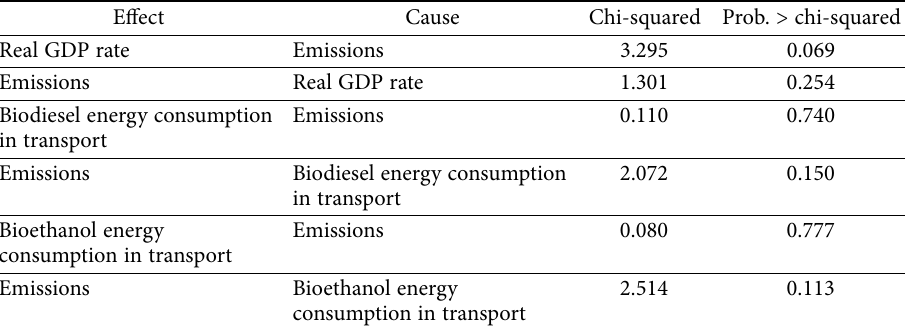
Table 6. Panel VAR-Granger causality Wald test for greenhouse emissions by energy consumption, economic growth, biodiesel and bioethanol energy consumption in transport in the EU-28 countries during